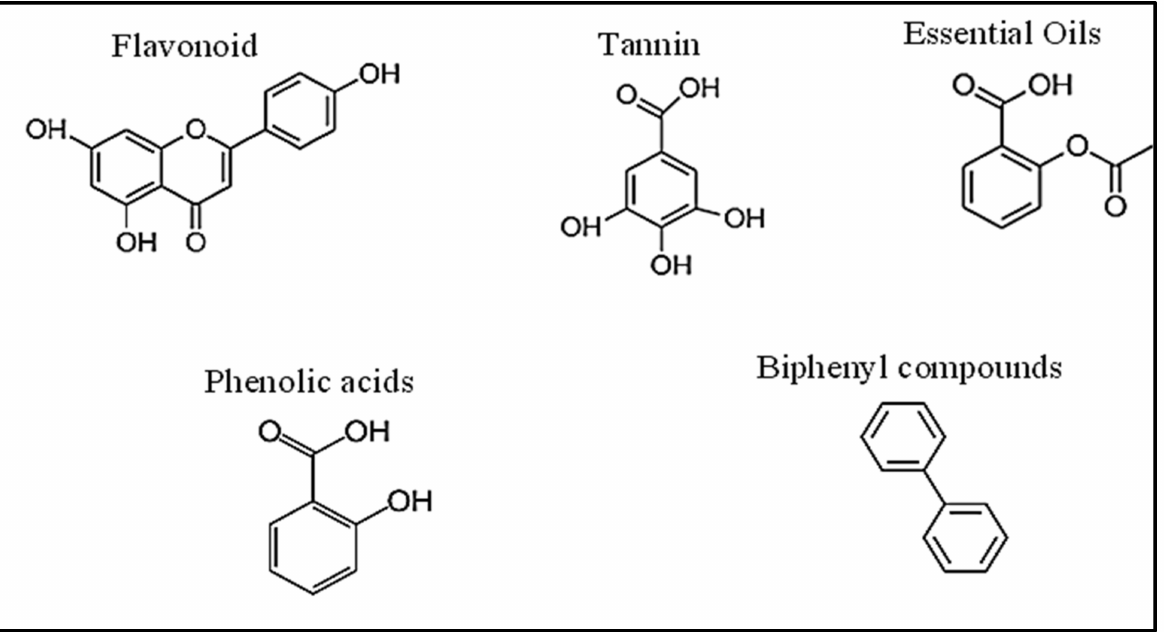
Figure 2. Available phytochemicals present in thyme plant